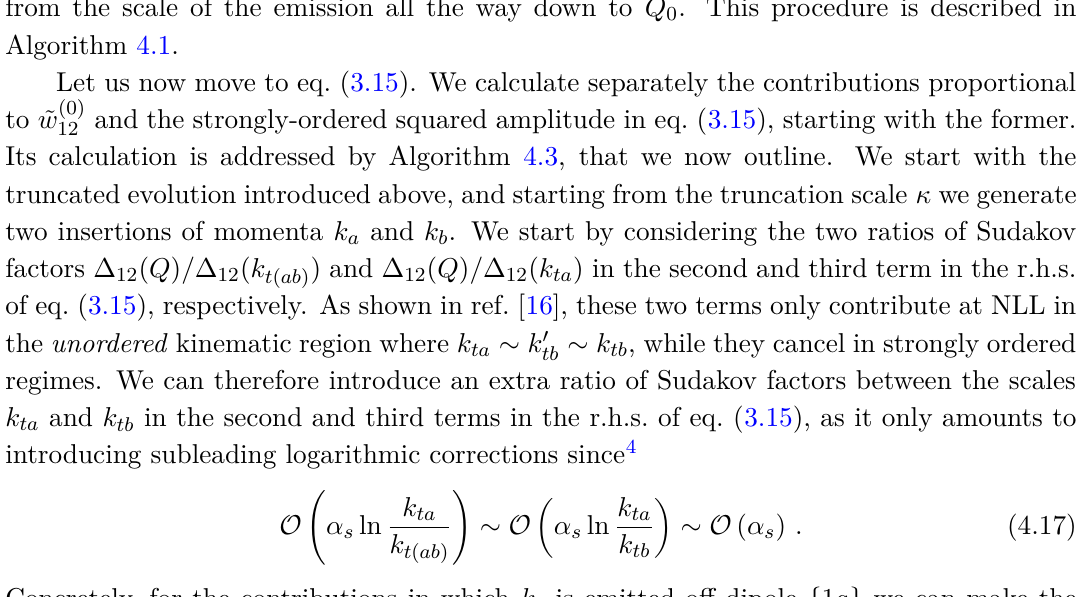
starting from the scale a